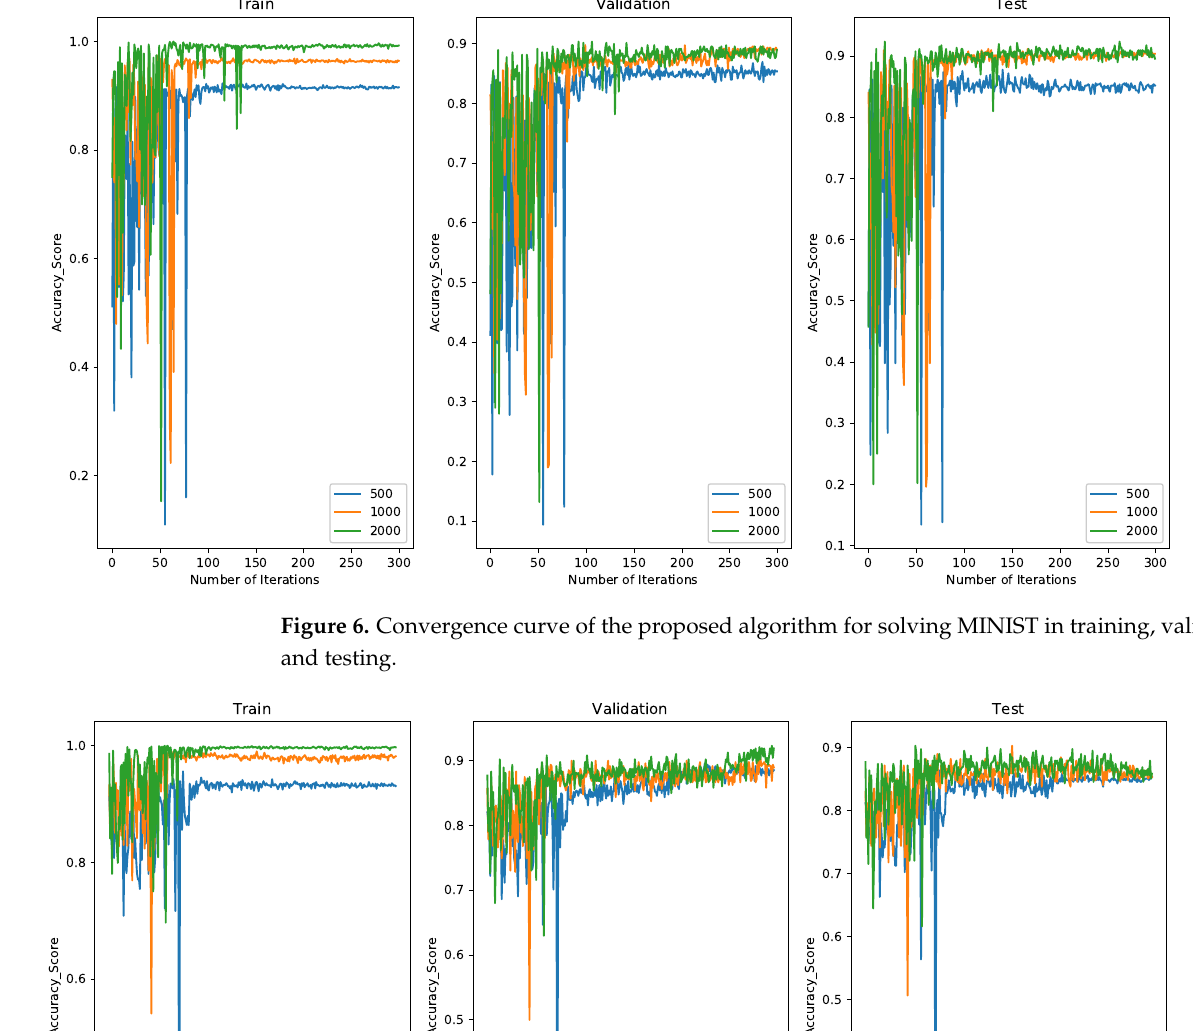
Figure 7. Convergence curve of the proposed algorithm for solving KTH in training, validation and